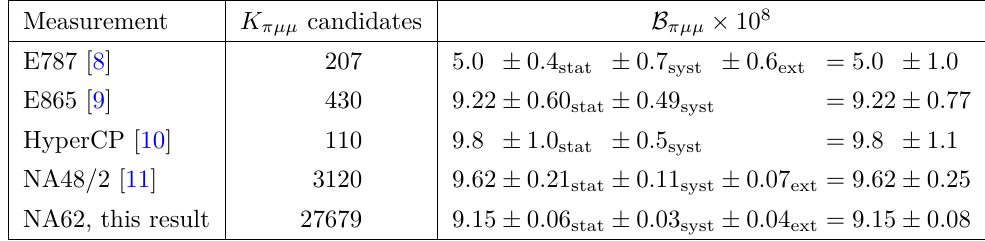
Table 2 . Comparison with the previous measurements of the K πµµ branching fraction.